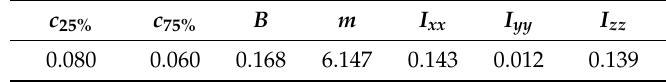
Table 5. Fish geometry, mass, and inertia properties, all expressed in SI